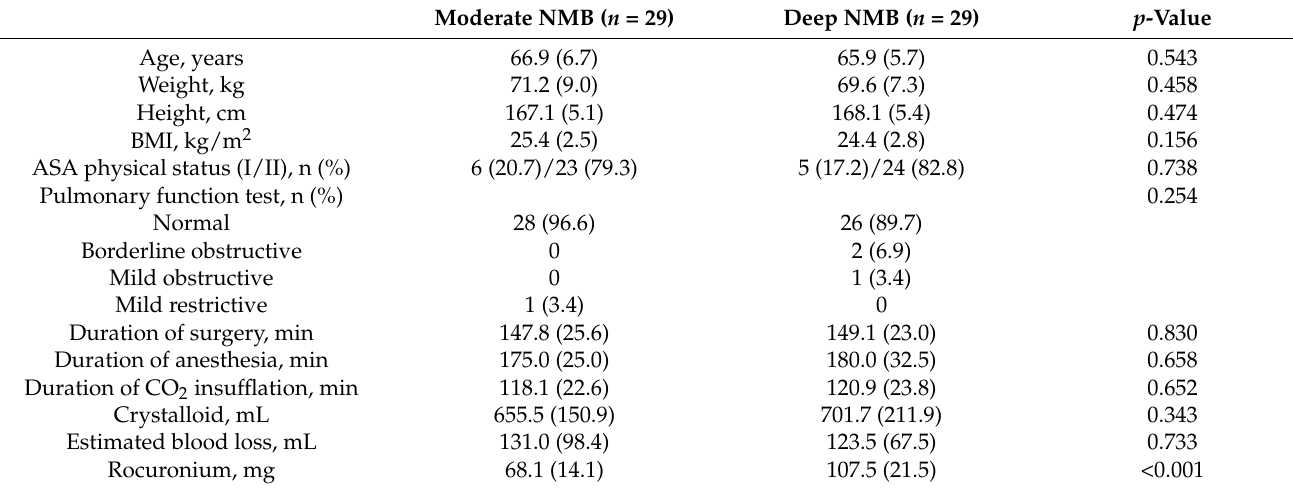
Table 1. Characteristics of patients, surgery and anesthesia.